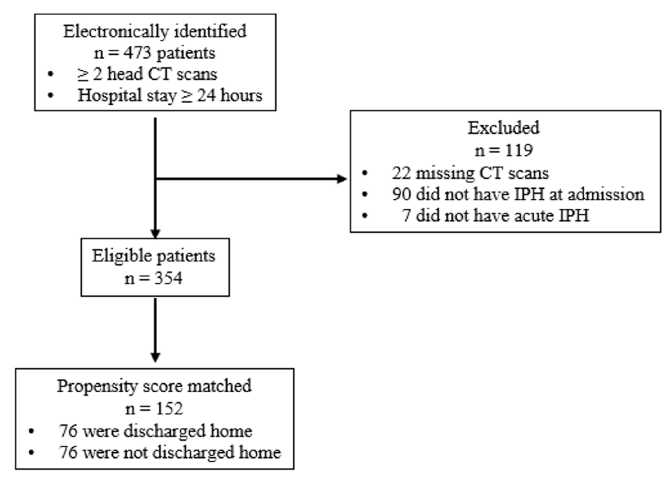
Figure 1. Patient selection diagram. CT, computed tomography; IPH, intraparenchymal contusion or hemorrhage.